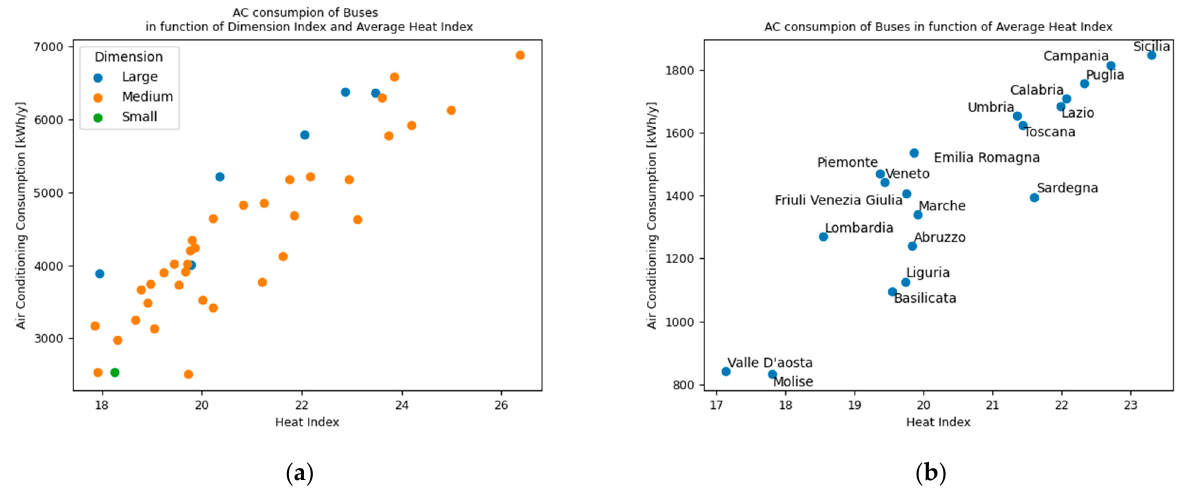
Figure 10. Left: annual air conditioning consumption in function of average Heat Index and City Dimension (1: small cities; 2: medium cities; and 3: large cities). Right: annual air conditioning consumption in function of average Heat Index for the considered regions.